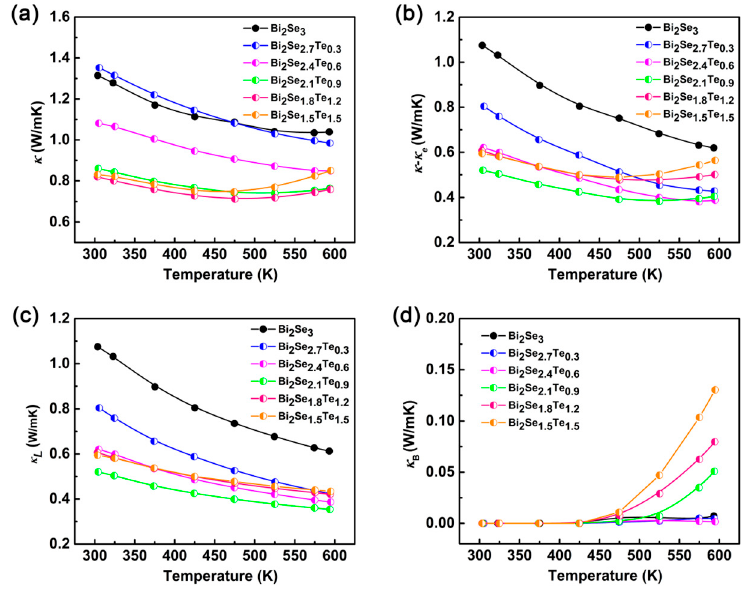
Figure 4. The temperature dependence of the ( a ) total thermal conductivity; ( b ) κ - κ B ; ( c ) lattice thermal conductivity; and ( d ) the bipolar thermal conductivity for Bi 2 Se 3 − x Te x samples.